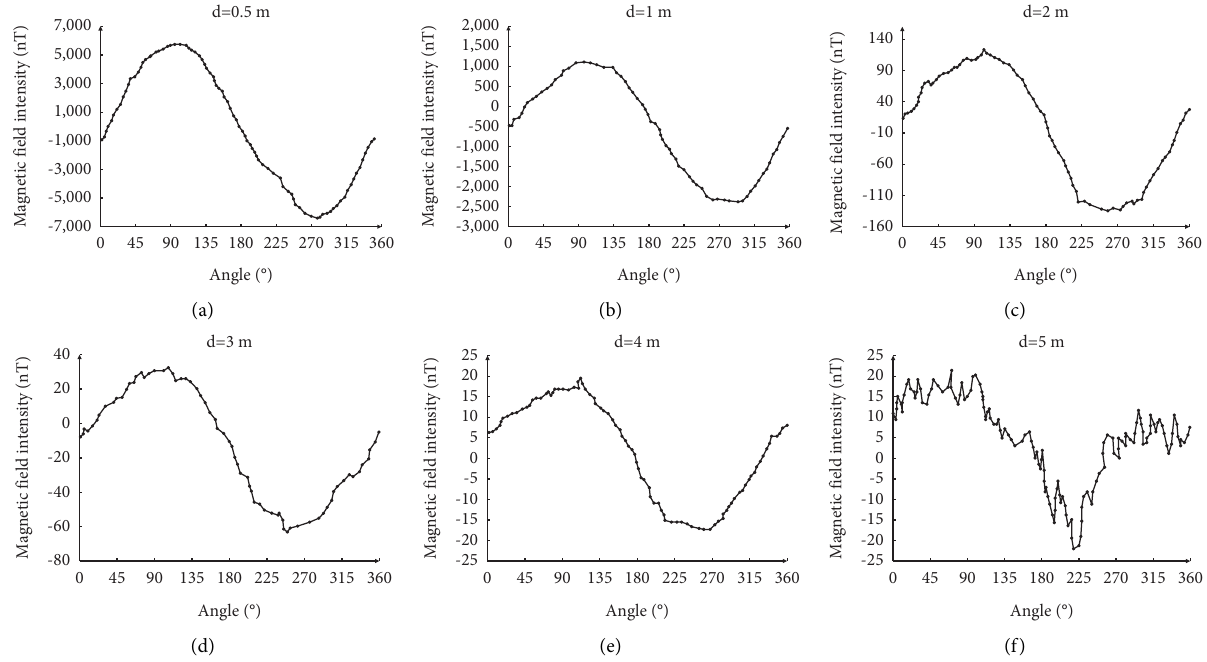
Figure 11: Calculation result of measuring point 1. (a) d � 0.5m. (b) d � 1m. (c) d � 2m. (d) d � 3m. (e) d � 4m. (f) d � 5m. d=0.5 m